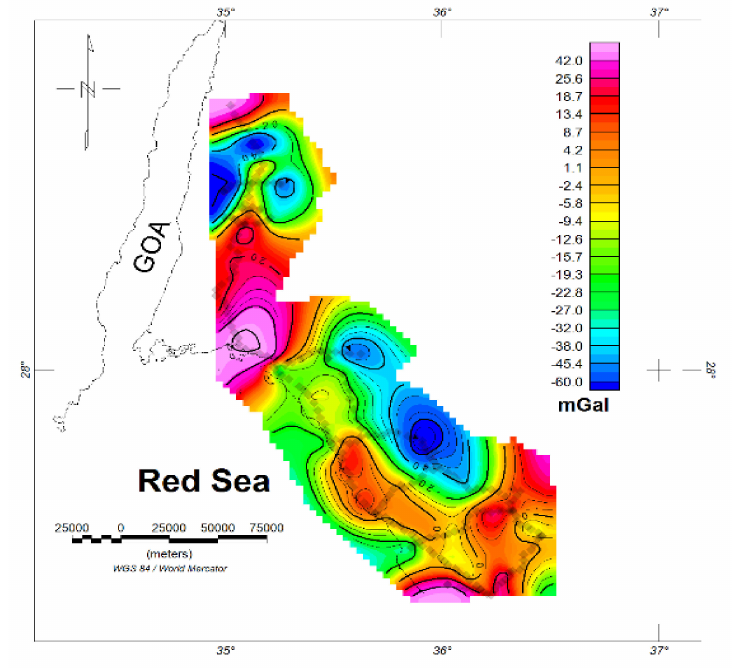
Figure 3. The Bouguer anomaly map of the study area. Dimmed squares show the location of the recorded gravity